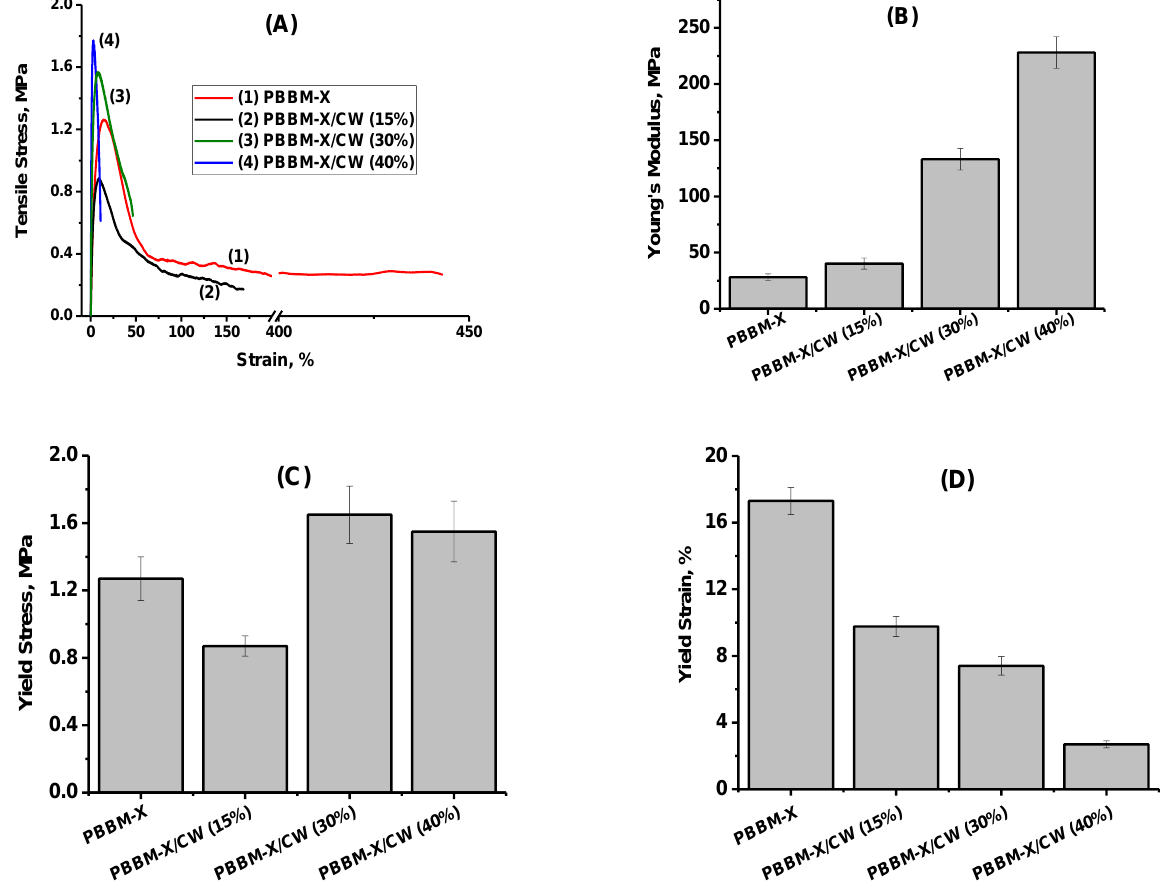
Figure 8. Typical stress-strain curves ( A ), Young’s modulus ( B ), yield stress ( C ), and yield strain ( D ) for the bioplastics.